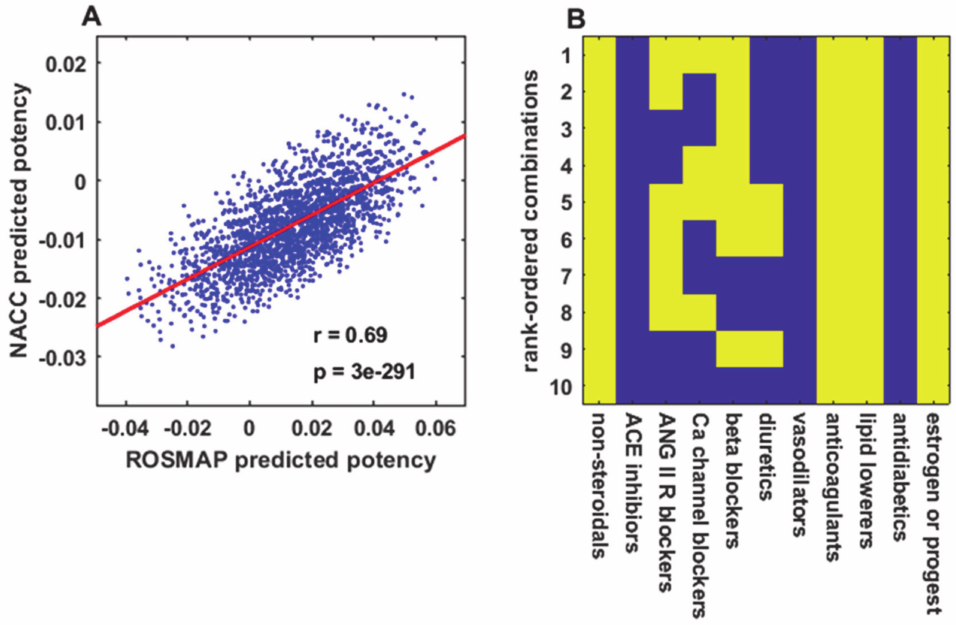
Figure 4. Predicting potent drug combinations jointly from ANNs trained on the ROSMAP or NACC datasets for the 2048 combinations of the 11 drug categories that do not target cognitive ability or mood. ( A ) The potencies predicted by ANNs trained on the ROSMAP or NACC datasets are highly significantly correlated. ( B ) The top ten drug combinations are ranked according to predicted potency (1 is highest) and displayed as a heat map (yellow, drug present; blue, drug absent). Each column represents one of the 11 drug categories. The top ten combinations include nonsteroidal anti-inflammatory (NSAID), antihypertensive, anticoagulant, and lipid-lowering drugs, as well as